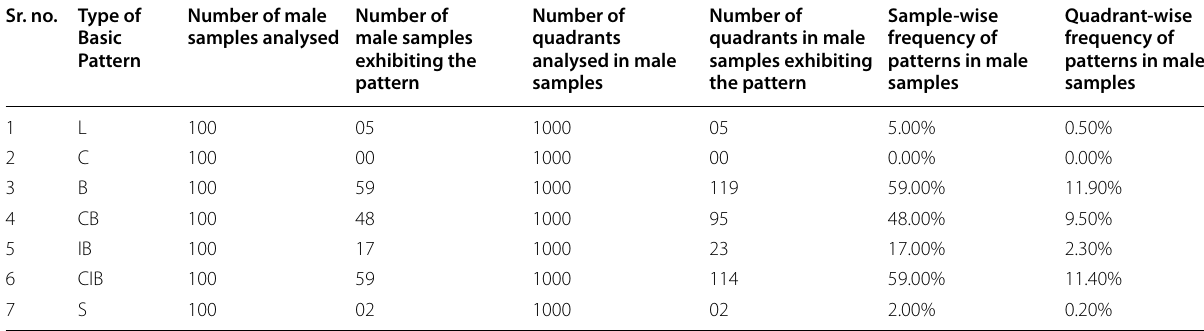
L , lines; C , curves; B , bifurcations; CB , curved bifurcations; IB , intersected bifurcations; CIB , curved intersected bifurcations; S , squares